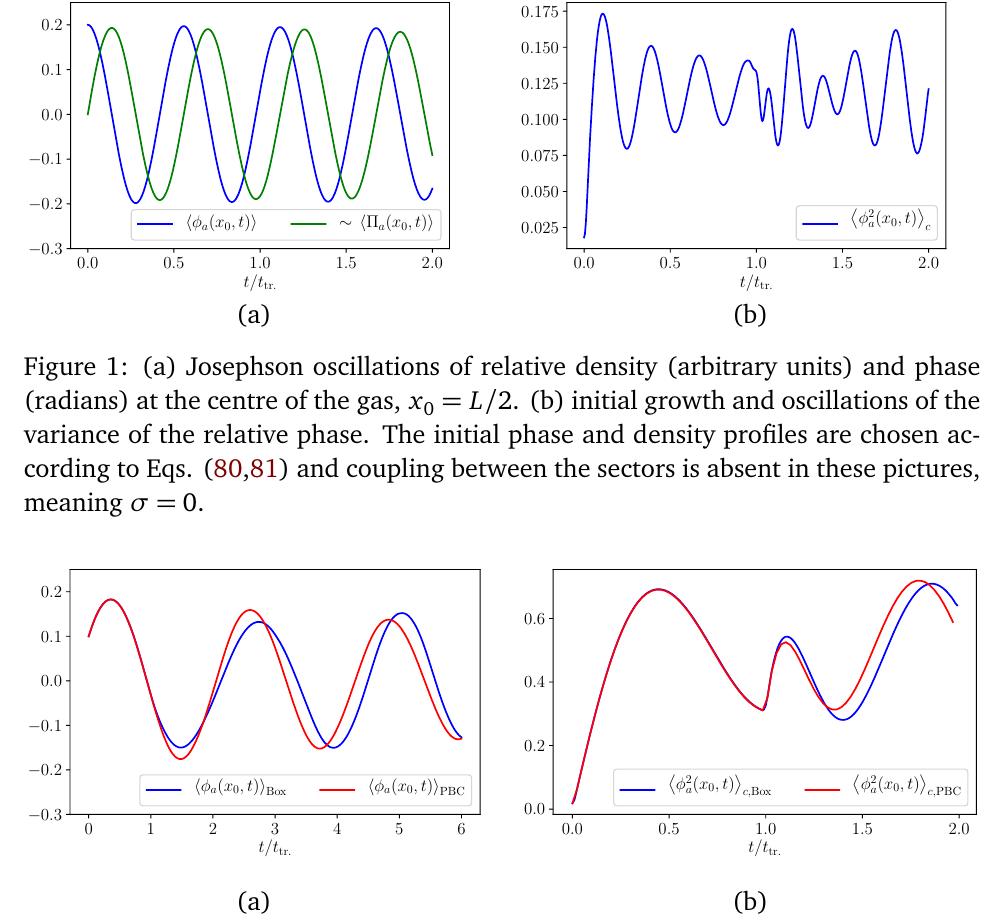
Figure 2: Comparison between results for box boundary conditions (blue) and peri- odic boundary conditions (red). The curves are in perfect agreement until the traver- = L / 2 v , after which deviations occur. (a) Josephson oscillations of phase sal time t tr = L / 2. (b) initial growth and subsequent oscil- (radians) at the centre of the gas, x 0 lations in the variance of the relative